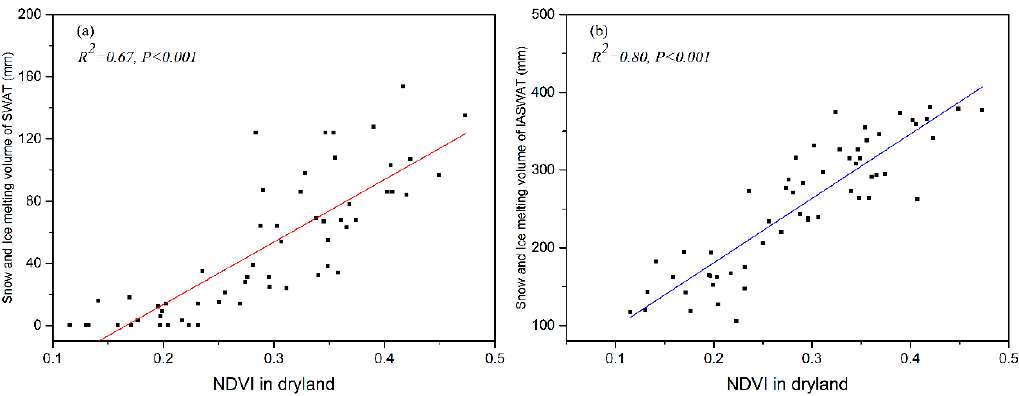
Figure 8. Relationship between the paddy field NDVI and snow and ice melt: ( a ) relationship between the amount of snow and ice melt calculated by the SWAT model and the paddy field NDVI; ( b ) relationship between the amount of snow and ice melt calculated by the SWATAI model and paddy field NDVI.